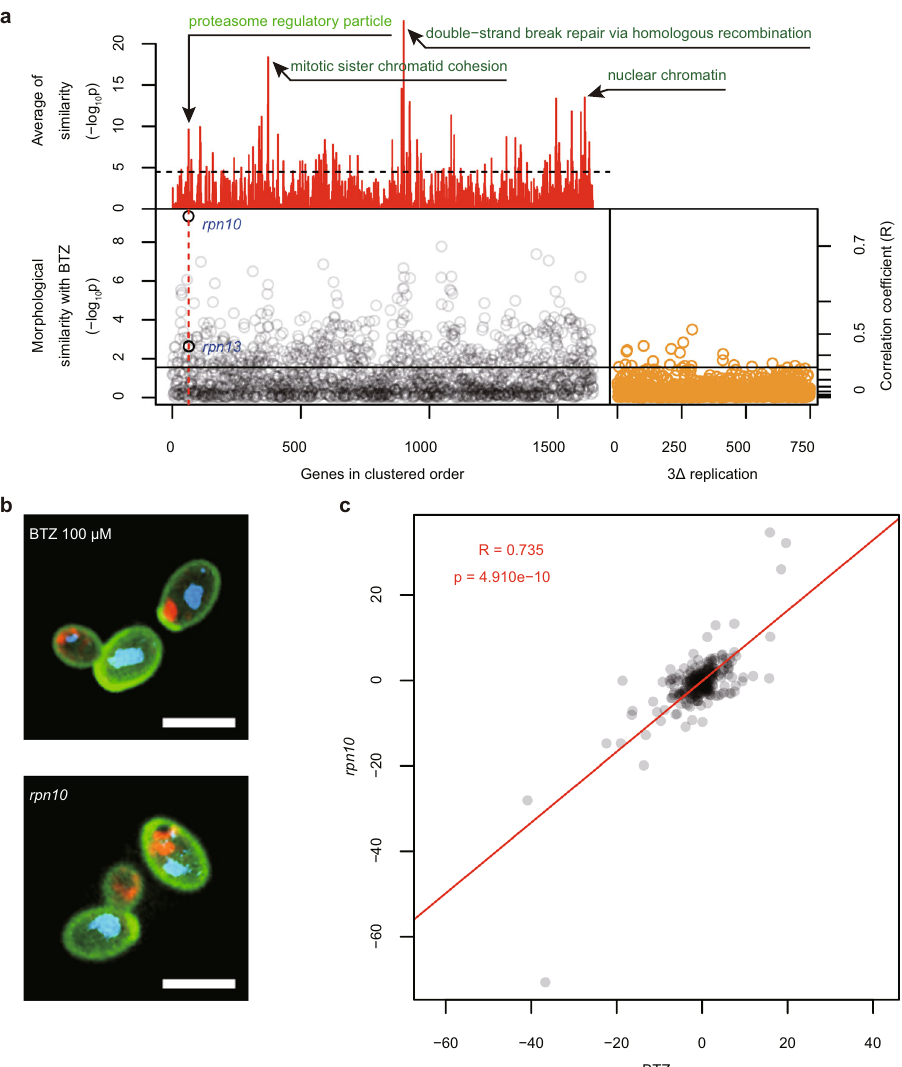
Fig. 4 Morphological pro fi ling of bortezomib-treated cells. a BTZ-treated cells exhibited the most similar morphology to rpn10 Δ . The RPN10 gene belongs to the signi fi cantly enriched functional gene group represented as “ proteasome regulatory particle (green text) ” . The red lines in the top panel represent 1486 groups of the functionally related genes, which are ordered by the similarity of gene functions. Brie fl y, the distance between genes was calculated using a Boolean matrix with genes as rows and GO as columns, hierarchical cluster analysis was performed based on the obtained distance matrix, and the gene-deleted strains were arranged in the order of the tree diagram of this cluster analysis (see “ Materials and Methods ” ). The y -axis indicates average similarities of functionally related genes to BTZ-treated cells as expressed by − log10p (likelihood ratio test). Dark green texts indicate the GO terms enriched in the signi fi cant top three groups of the lowest p value by the likelihood ratio test among the detected gene groups. The horizontal dashed line indicates a threshold p -value of 0.05 after Bonferroni correction. Enriched GOs in the detected gene groups ( p < 0.05 after the Bonferroni correction) are listed in Supplementary Data 2. The lower panel shows the most similar mutant and the mutant belonging to the functionally related gene shown in the top panel (black), 1635 quadruple mutants (grey), and 749 replicates of 3 Δ (orange, ordered by the date of data acquisition). The morphological similarity ( y -axis) is represented by − log10p, which was calculated by Gaussian distribution fi tted to the t-distribution of correlation coef fi cients from the wild type ( n = 749). The horizontal solid line indicates threshold p -values at FDR = 0.05. The morphological similarity was calculated using fi ve independent biological experiments with bortezomib-treated cells. Signi fi cantly similar mutants (FDR = 0.05) are listed in Supplementary Data 1. b Triple-staining images of cells of 3 Δ treated with BTZ and rpn10 Δ in the 3 Δ background ( rpn10 ). The cell wall (green), nuclear DNA (blue), and actin cytoskeleton (red) are shown. Scale bars indicate 5 μ m. c Correlation coef fi cient of morphological pro fi les between BTZ-treated cells and rpn10 Δ . PC scores of 259 PCs were plotted between BTZ-treated cells ( x -axis) and rpn10 Δ ( y -axis) after chemical treatment. R , p ; the redacid dilactone was made from ferulic acid by line indicates the Pearson product-moment correlation coef fi cient, p -value calculated by the t-distribution of 3 Δ replication ( n = 749), and the linear regression line, indistinguishable from noise 22 . As a result, among 321 deletion signi fi cantly similar (one-sample upper-tailed test by Gaussian distribution, FDR = 0.05; Fig. 5b and Supplementary Data 13). The mutants with signi fi cantly high HMA (one-sample upper-tailed test deletion mutants with high holistic morphological abnormality by Gamma distribution, FDR = 0.05), signi fi cantly similar mutants (HMA) tended to show distinct and characteristic morphological (one-sample upper-tailed test by Gaussian distribution, FDR = phenotypes, while those with low HMA showed morphologies 0.05) increased to 69.2% (Fig. 5b and Supplementary Data 13).